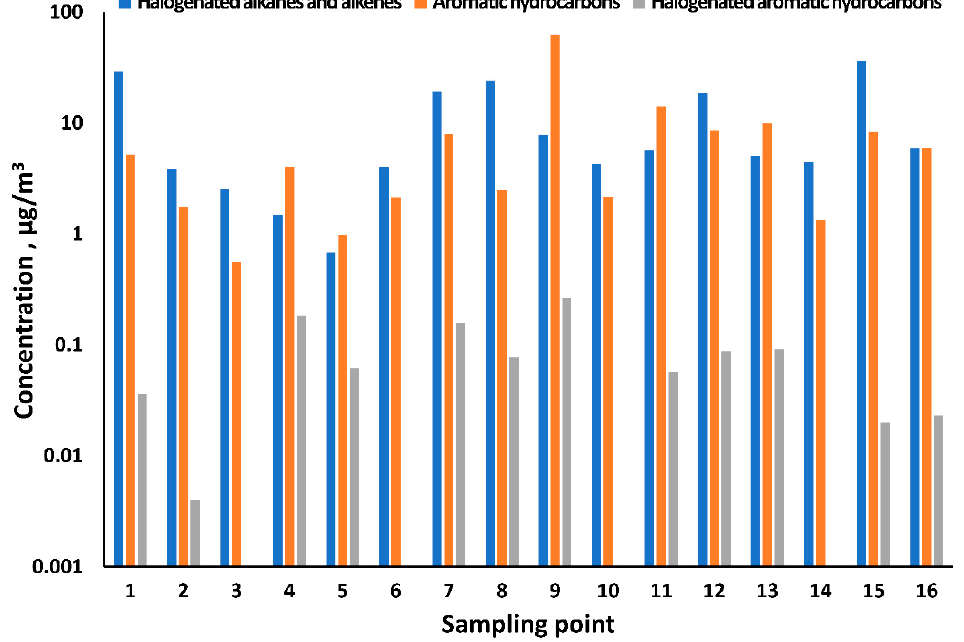
Figure 3. The sum concentrations of VOC groups in the studied air samples. The first group was dominated by 1,1,2-trichlorotrifluoroethane (CFC-113, Freon 113), which is still widely used as a refrigerant and has a high ozone-depleting potential. Despite the abandonment of its production, the concentration of this compound in the atmosphere decreases very slowly and at present its molar fraction in the tropospheric air averages 70–80 ppt, which corresponds to a level of ~0.5 µ g/m 3 [28,29]. The concentrations measured in this study at most sampling points were slightly higher (1–5 µ g/m 3 ), and at five points (1, 7, 8, 12, 15) turned out to be considerably high (18–35 µ g/m 3 ). It is noteworthy that these sampling sites corresponded to the mouth zones of large rivers (Northern Dvina, Ob, Yenisei, Lena) flowing through industrial centers and were close to the ports on the Arctic Ocean coast. Other halogenated aliphatic hydrocarbons were represented mainly by carbon tetrachloride (0.7–1.7 µ g/m 3 ), chloroform (0.1–1.9 µ g/m 3 ), and 1,2-dichloroethane (0.1–0.3 µ g/m 3 ). Tetrachloroethene, 1,2-dichloropropane, 1,1,1- and 1,1,2-trichloroethane were also found in low concentrations comparable to their LOQ. The detection of appreciable amounts of bromoalkanes is of particular interest. Bromo- form (0.01–0.23 µ g/m 3 ), present in all selected samples, and dibromomethane (0.03–0.07 µ g/m 3 ), detected in 12 air samples, predominated among them. These com- pounds have already been repeatedly found worldwide in the marine environment [30,31], including the Arctic snow [21,22]. They are of biogenic origin associated with the vital activity of macroalgae, phytoplankton, bacteria, and photochemical processes in the surface layer of the ocean [32,33]. Traces of bromochloromethanes found in some samples have the same origin [33]. It is worth noting that along with some other halogenated compounds, bromoform is included into the CEAC list